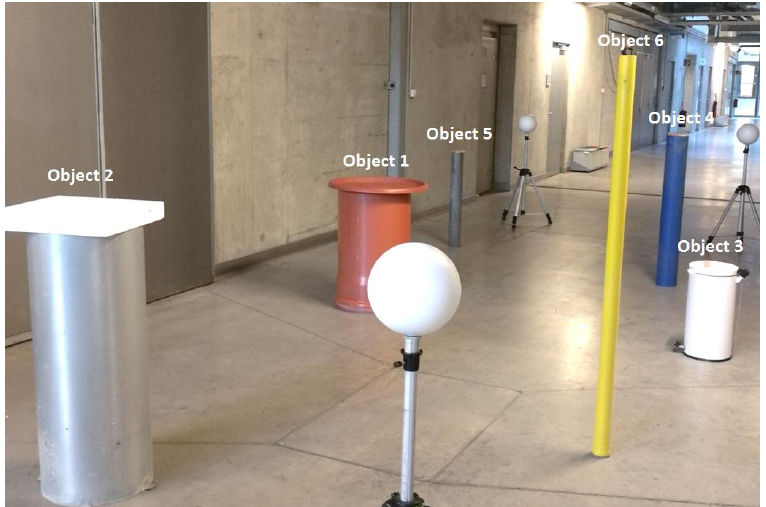
Figure 6. Cylindrical reference objects for evaluation of point cloud quality and diameter fitting. Table 2. Overview of the objects in terms of shape, material, and diameter.